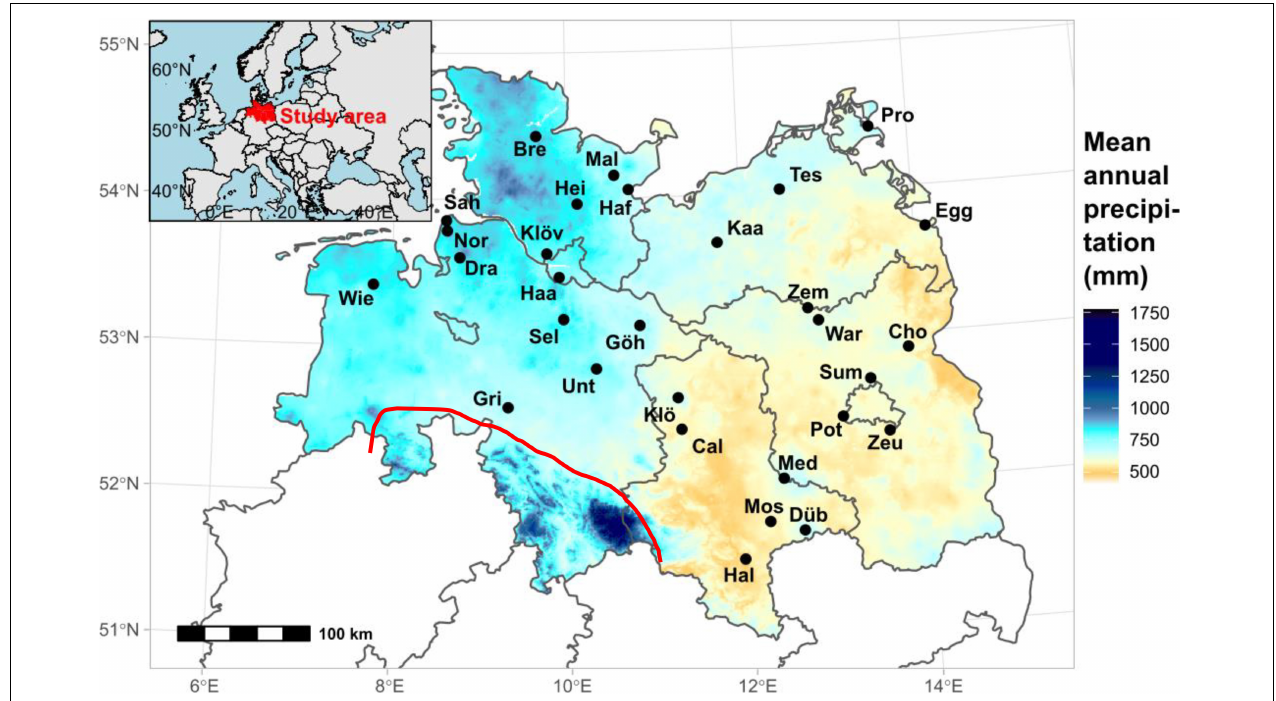
FIGURE 1 | Mean annual precipitation (MAP in mm, 1991–2018, source: DWD) in the study area and location of the 30 studied forest sites in the North German Lowlands on Pleistocene substrates across a climate continentality gradient from W-NW to E-SE. At the 30 beech forest sites, the climate sensitivity of tree growth was analyzed in a companion study (Weigel et al., submitted) 1 . The red line marks the northern range limit of the central German low mountain range. Shown are the federal state boundaries of Lower Saxony, Schleswig-Holstein, Saxony-Anhalt, Brandenburg, Mecklenburg-Vorpommern and Hamburg, Bremen and